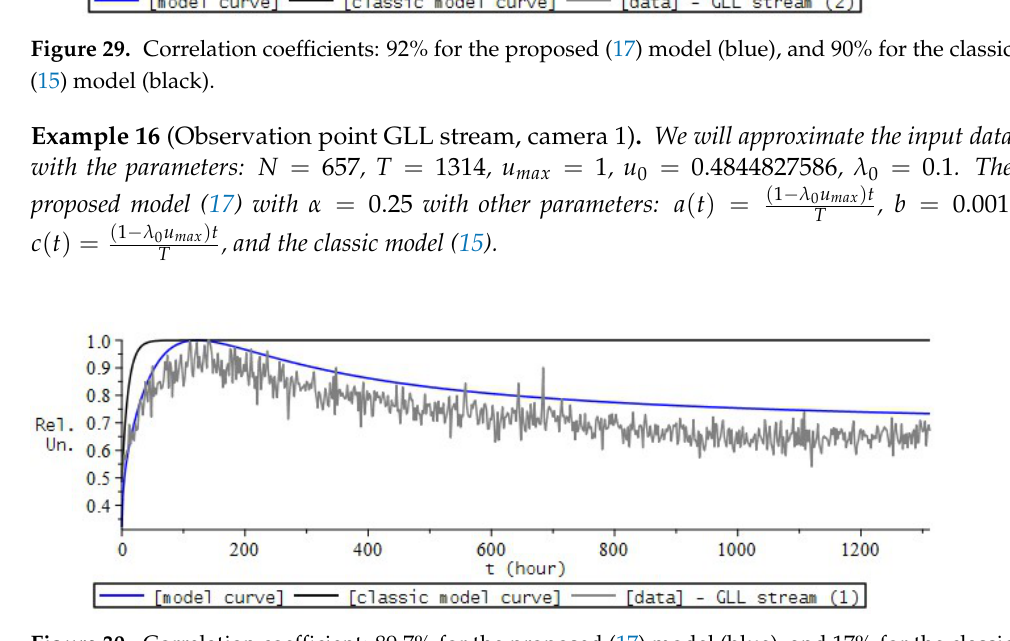
Figure 30. Correlation coefficient: 89.7% for the proposed (17) model (blue), and 17% for the classic (15) model